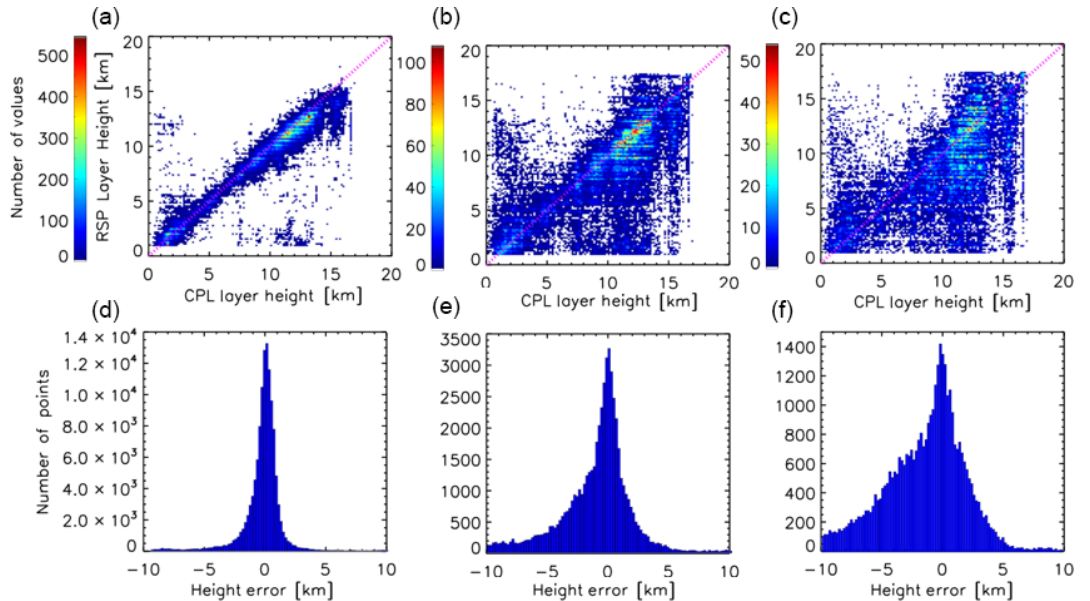
Figure 6. Same as Fig. 4 but for the dual band